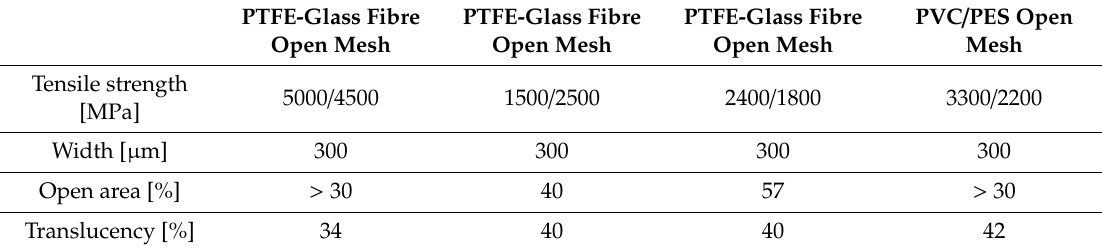
Table 1. Typical examples of embedded textiles for enhanced glass facades (selection).